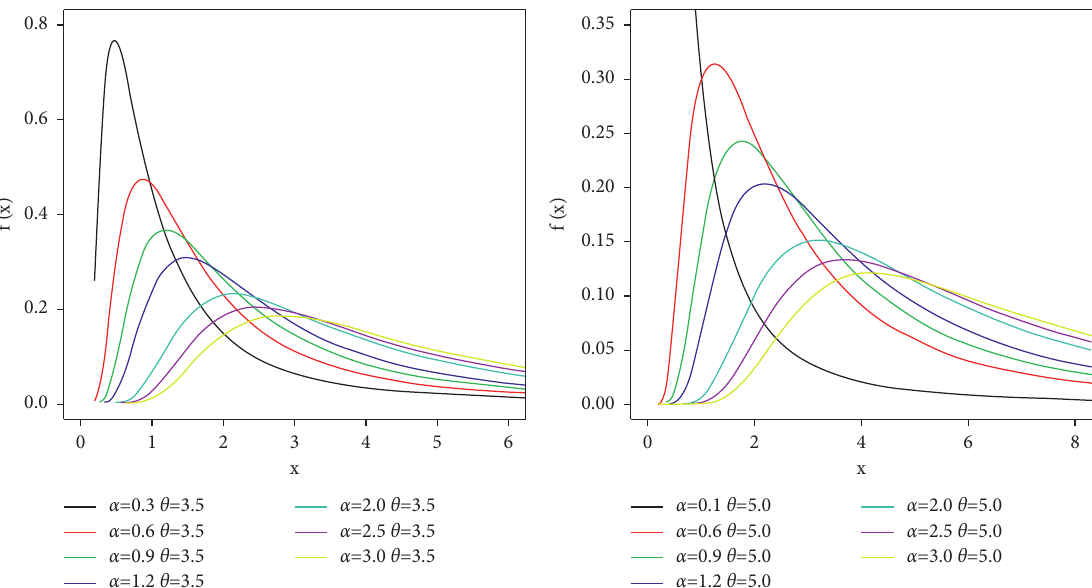
Figure 1: The pdf of the TLIL distribution for different values of